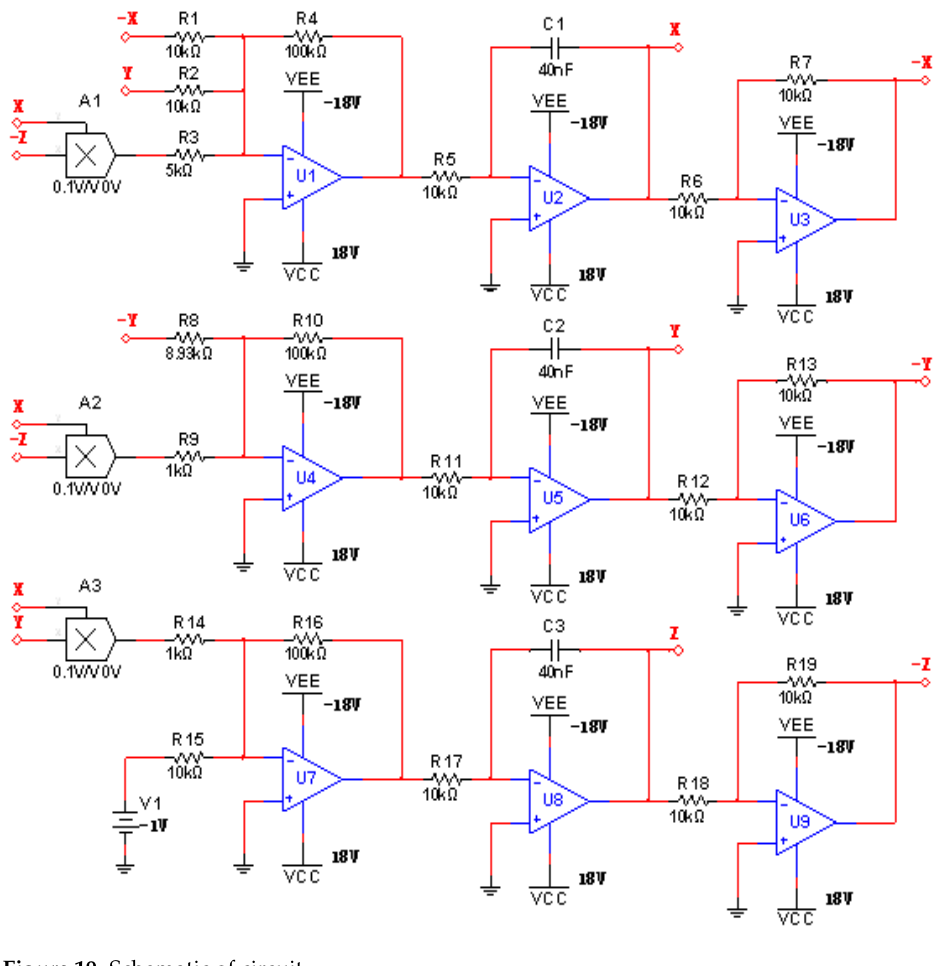
Figure 19. Schematic of